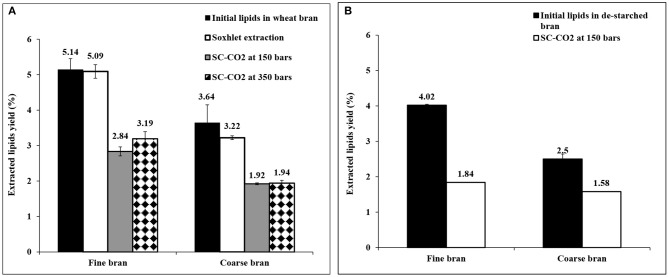
Extracted lipids from fine and coarse wheat brans (A) using SC-CO2 and Soxhlet extraction methods without extraction of starch, (B) using SC-CO2 extraction method after extraction of starch. The total lipids were determined using the chloroform-methanol-water extraction method, as indicated in section Analysis of Total Lipids, and targets a broader range of lipid compounds than the used extraction methods due to extracting more polar lipids which naturally gives lower yield when SC-CO2 or Soxhlet are used. The figure shows the average ± std deviation of three experiments (except for SC-CO2 extracted lipids from de-starched bran in (B), which was a single experiment), the data is given as % lipids (dry weight) of bran dry weight.